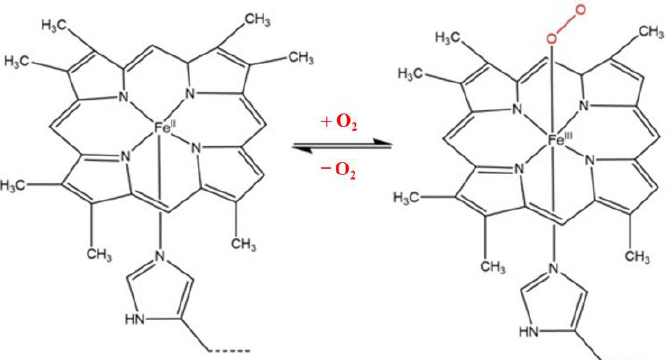
Figure 1. A normal heme complex (Fe protoporphyrin IX ) showing the attachment and release of an oxygen molecule.